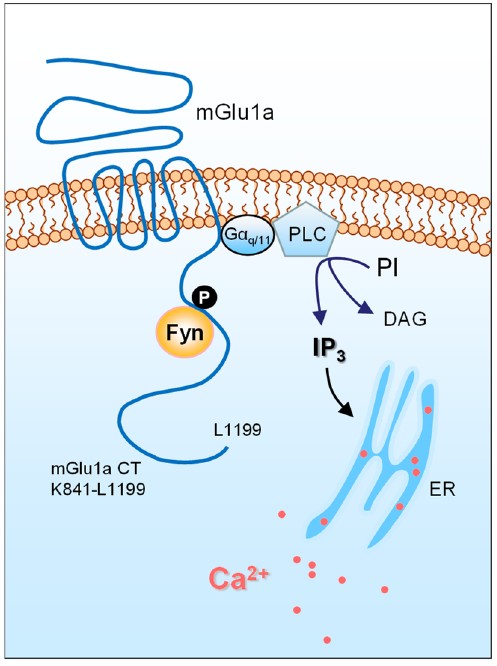
Figure 1. A schematic diagram illustrating an interaction between Fyn and a metabotropic gluta ‐ mate receptor. The mGlu1a receptor is coupled to G α q/11 proteins. Ligand stimulation of mGlu1a receptors activates PLC and subsequently hydrolyzes PI to yield DAG and IP 3 , which triggers an intracellular release of Ca 2+ from the endoplasmic reticulum (ER). Released Ca 2+ could modulate various downstream signaling molecules and pathways to control synaptic transmission and plasticity. The SFK member Fyn binds to the mGlu1a CT. Through phosphorylating a tyrosine residue in the mGlu1a CT, Fyn supports surface trafficking and IP 3 signaling of the receptor.